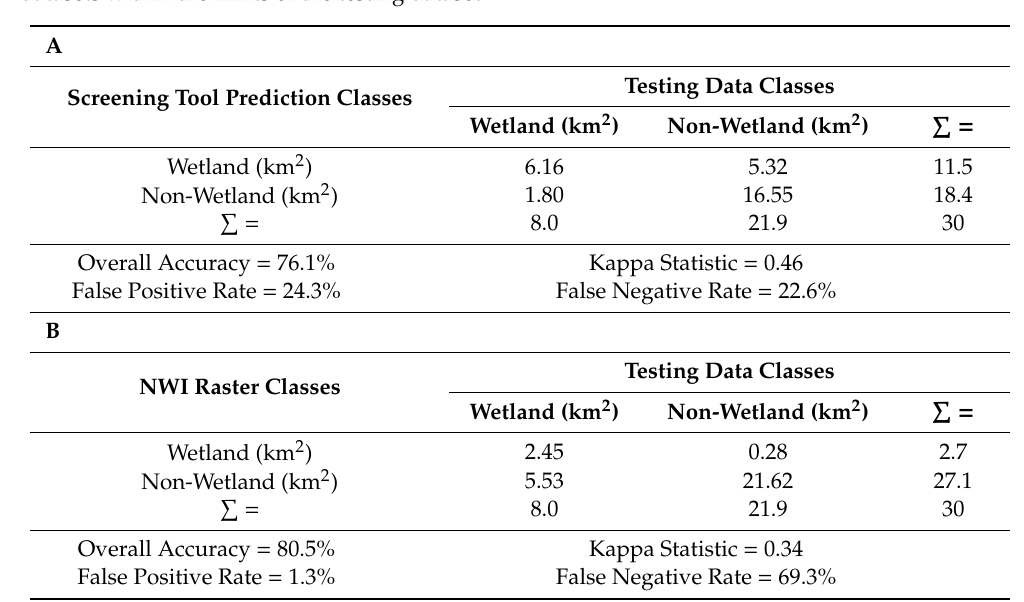
Table 4. Confusion matrices used to assess the accuracy of screening tool predictions ( A ) and the NWI raster ( B ), where testing data classes are represented in columns and both tool and NWI classes are represented in rows. Both accuracy assessments quantify the level of agreement achieved by respective datasets within the limits of the testing